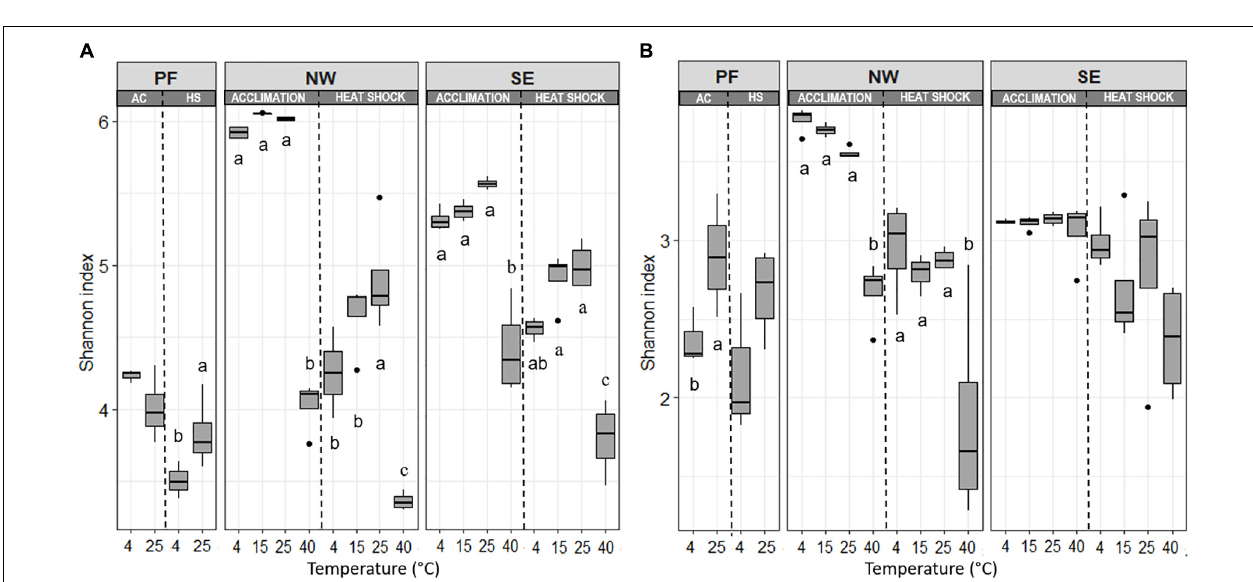
FIGURE 2 | Changes in (A) specific respiration activity and (B) the C:N:P ratio of acquiring enzymes at the end of the incubation. Letters indicate significant differences ( p < 0.05) between treatments (temperatures) for acclimation (AC) and heat shock (HS), assessed separately with Tukey post hoc tests. Enzymes are plotted in relative proportions of carbon – (C), nitrogen – (N), and phosphorus – (P) acquiring enzymes. Soil origins: PF, permafrost; NW, active layer on north-western slope; SE, active layer on south-eastern slope. Temperatures: PF soils 4 and 25 ◦ C; NW and SE soils 4, 15, 25, and 40 ◦ C.